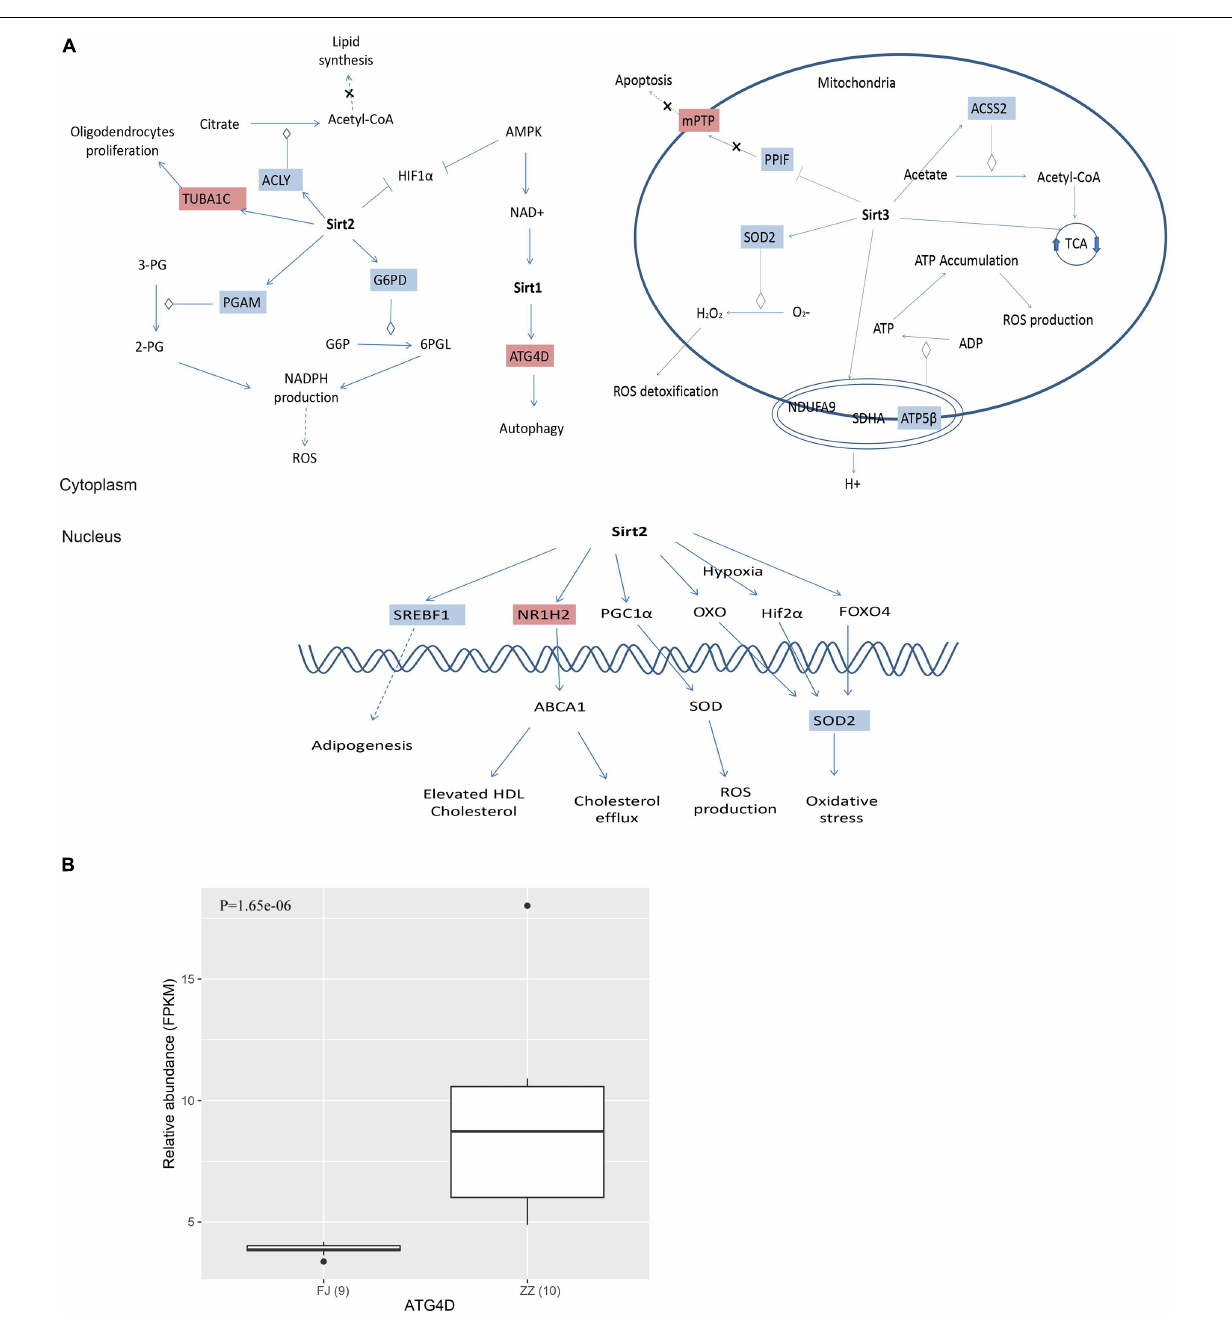
Table 8 ), ATG4D (Autophagy Related 4D Cysteine